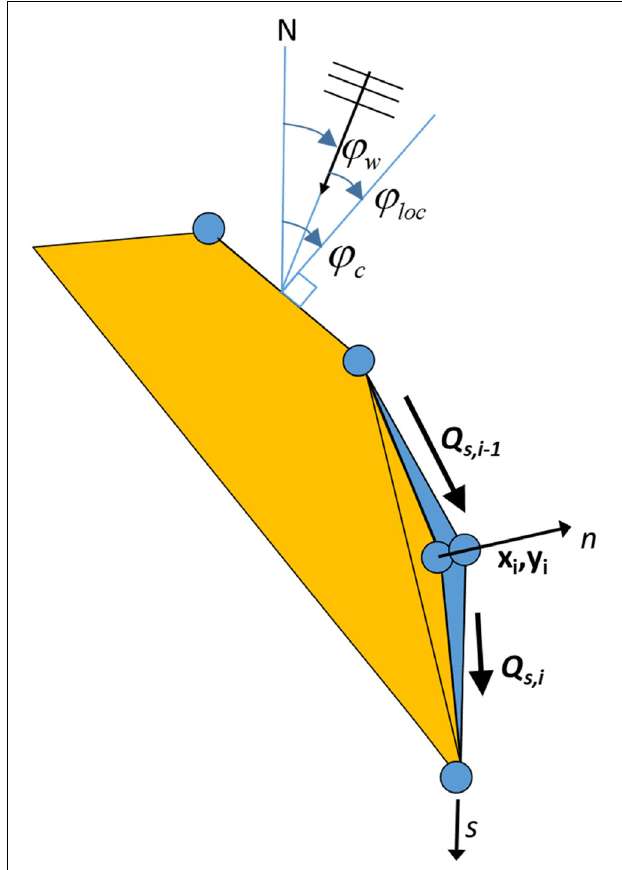
FIGURE 1 | Coastline-following coordinate system and definition of wave and coast angles. ϕ c is the orientation of the shore normal with respect to North; ϕ w is the angle of incidence of the waves with respect to North and ϕ loc the local angle between waves and coast, defined as ϕ c − ϕ w